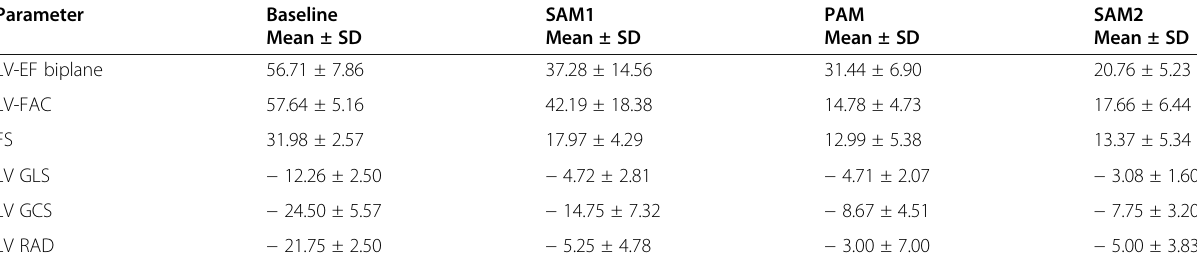
Table 1 Comparison of echocardiographic parameters measured during baseline, SAM1, PAM, and SAM2